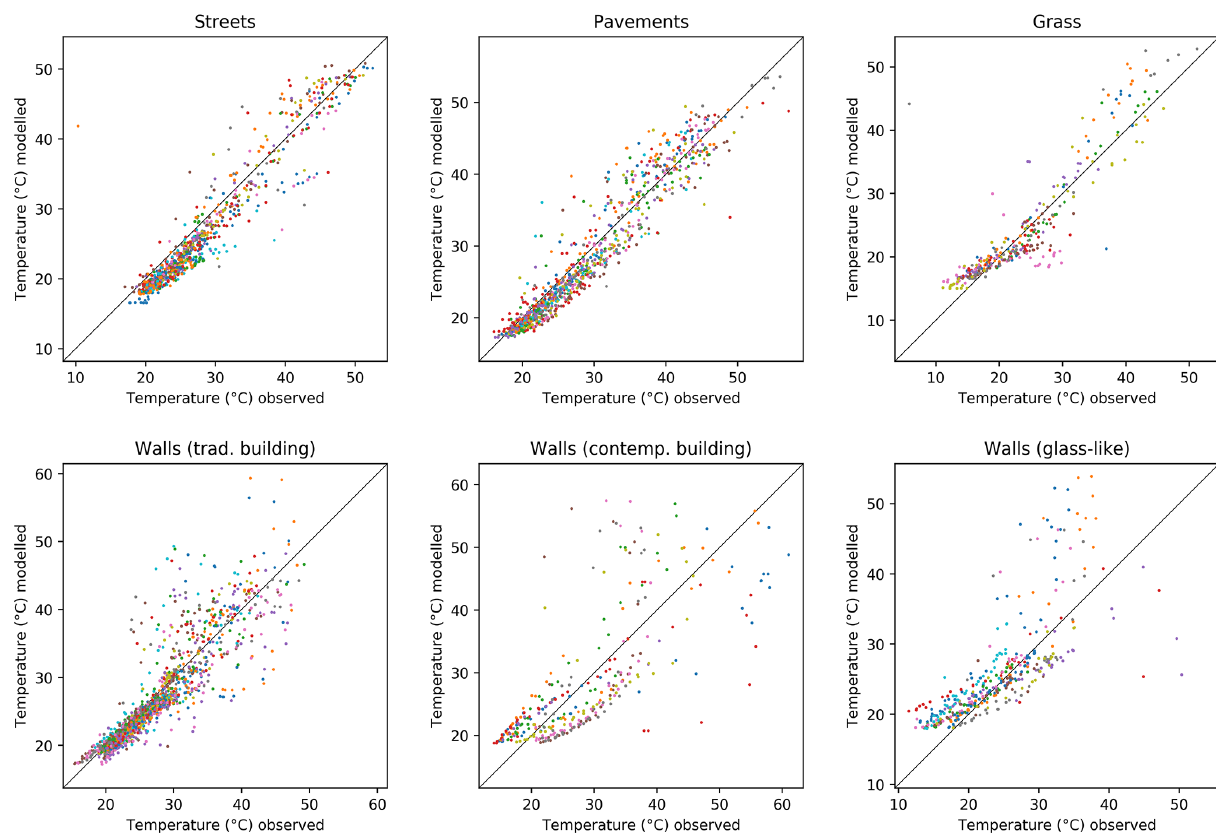
Figure 12. Scatter plots of the modelled and observed surface temperature for particular types of the surfaces in Table S7 during the summer e2 episode. Individual evaluation points are plotted using dots of different